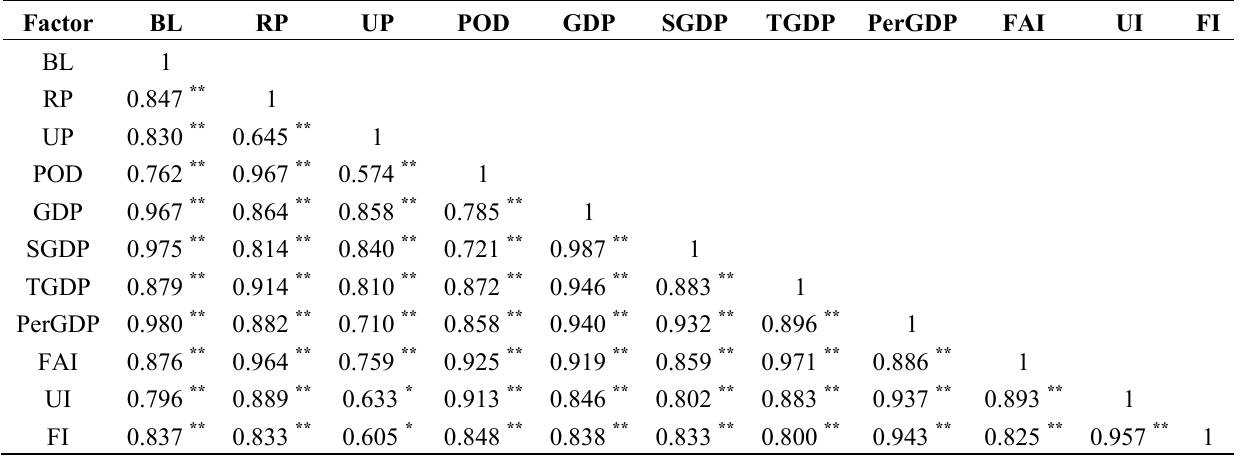
Table 5. Correlations among variables for the period of